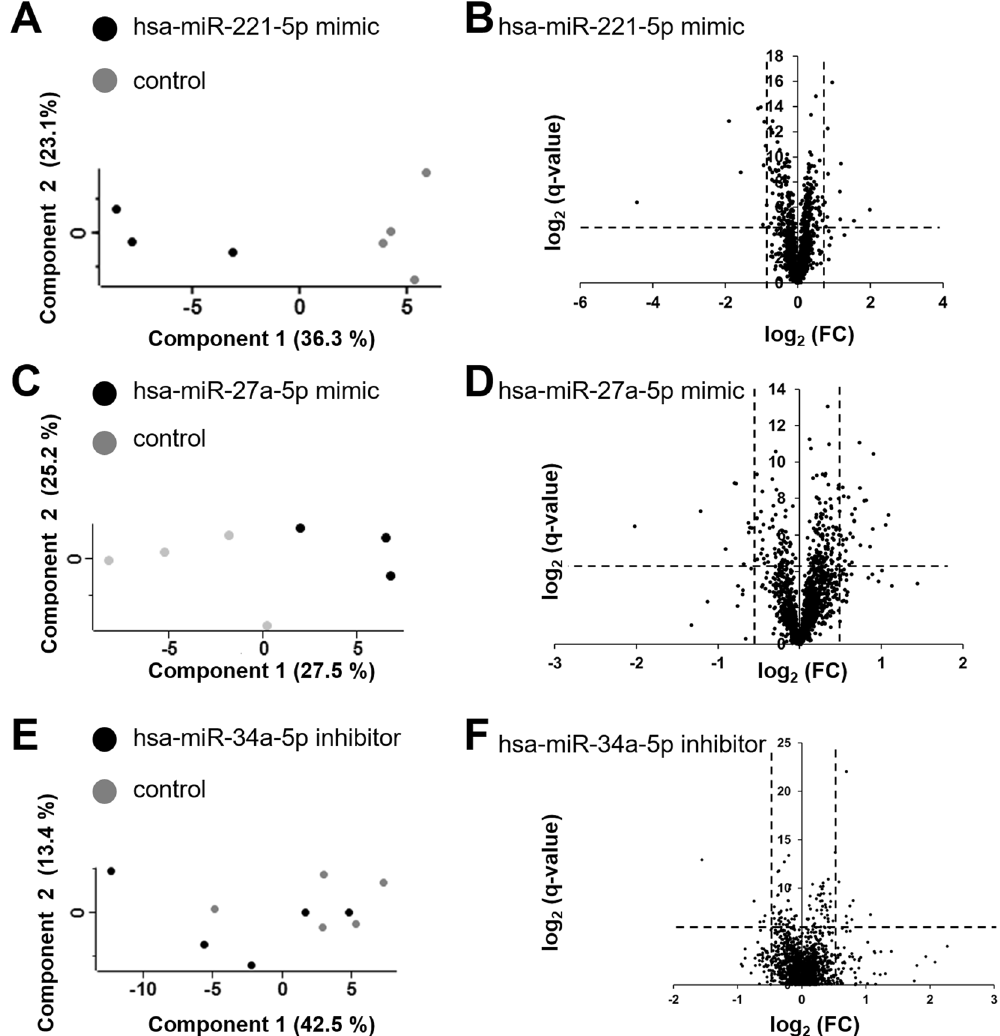
Figure 6. Proteome analysis of miRNA mimic/inhibitor transfected XXL-USSC at 3d XXL. Principle component analyses (PCA) and Volcano Plots of 3d XXL-USSC transfected with hsa-mir-221-5p mimic ( A,B ), hsa-mir-27a-5p mimic ( C,D ) and hsa-mir-34a-5p inhibitor ( E,F ) in comparison to n.t. siRNA transfected USSC (unspecific control). ( A,C,E ) PCAs showing separation of mimic/inhibitor transfected 3d XXL-USSC from control transfected 3d XXL-USSC. ( B,D,F ) Corresponding Volcano plots displaying differentially abundant proteins from transfected 3d XXL-USSC compared to the unspecific